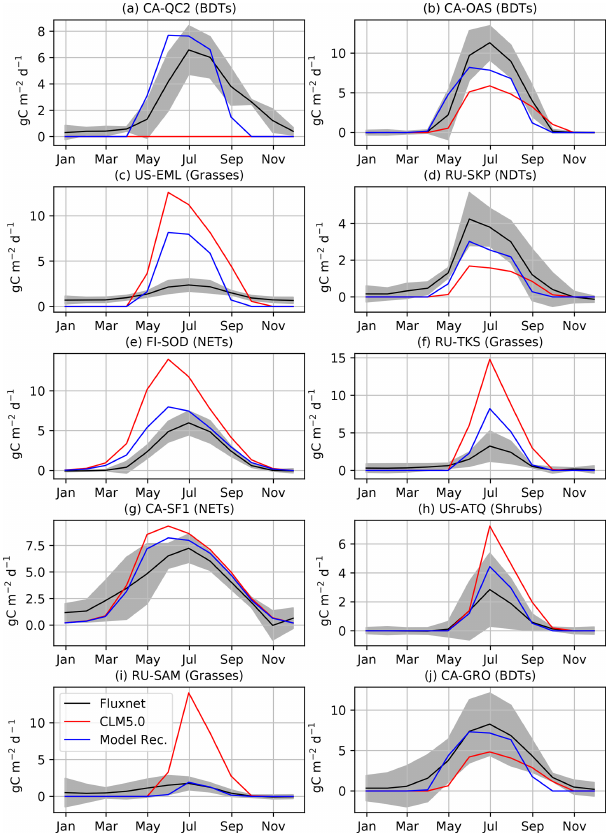
Figure 4. Comparison of GPP at flux tower sites to the CLM5.0 release and the results of our model development. We performed model development at CA-QC2 (mixed forest site in Quebec), CA- OAS (Aspen forest in Saskatchewan), US-EML (Eight Mile Lake tundra location), and RU-SKP (Yakutsk Spasskaya Larch Forest). We did additional comparisons with FI-SOD (Sodankylä, Finland), RU-TKS (Tiksi grasslands), CA-SF1 (Saskatchewan boreal forest), RU-COK (Chokurdakh Tundra shrubs), RU-SAM (Samoylov grass- lands), and CA-GRO (Groundhog River Boreal